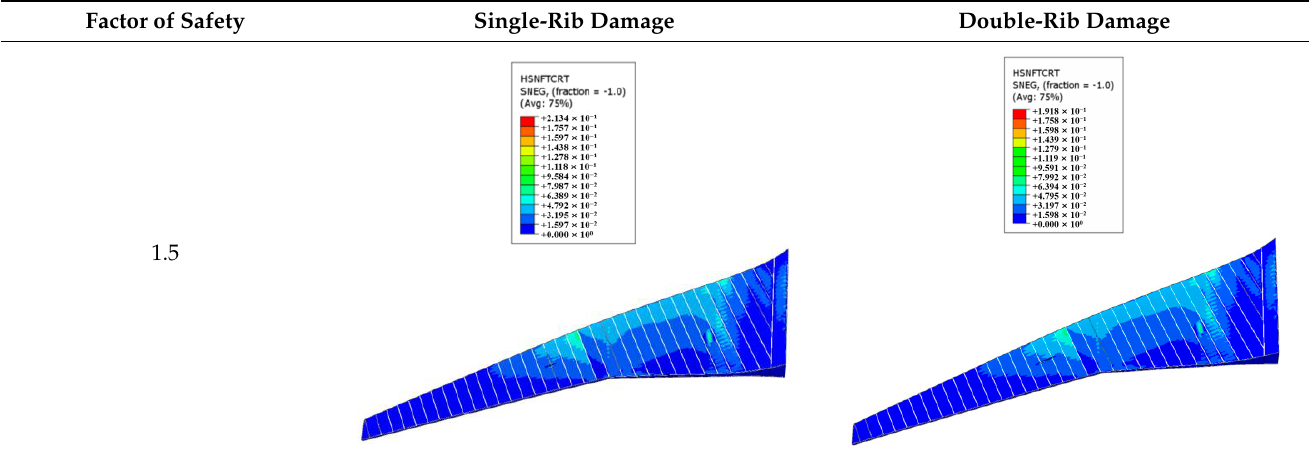
Table 17. Results of Hashin fiber tensile failure criterion of single-rib and double-rib damage BWB wings at different values of F.o.S.